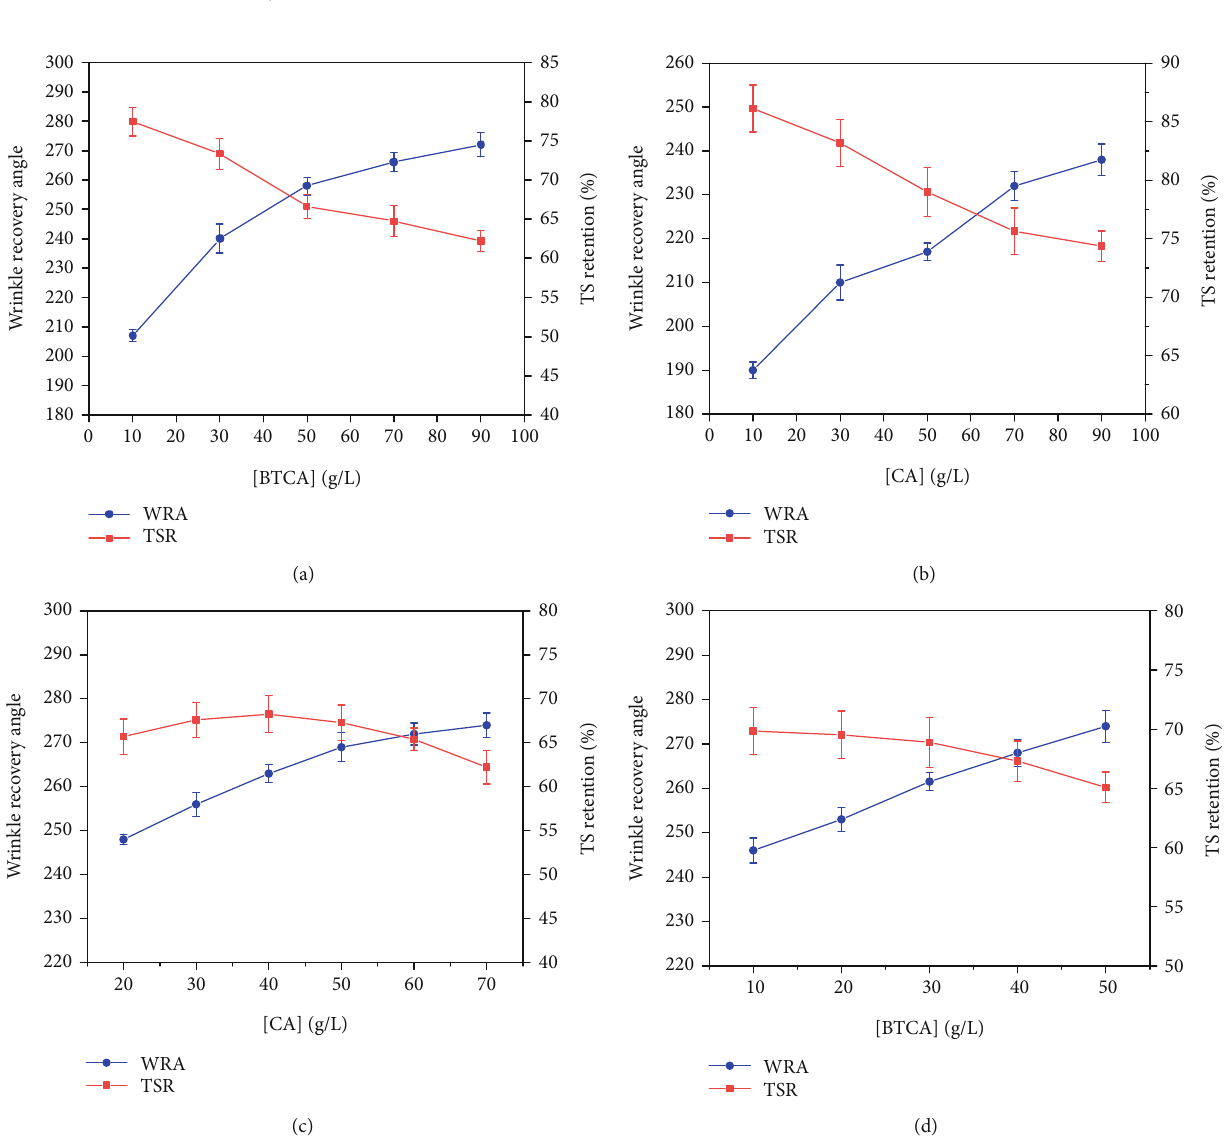
Figure 7: (a) WRA and TS retention of fabrics treated with BTCA. (b) WRA and TS retention of fabrics treated with CA. (c) E ff ect of changing concentration of CA on fabrics treated with BTCA/CA combination with 50g/L BTCA. (d) E ff ect of changing concentration of BTCA on fabrics treated with BTCA/CA combination with 40g/L